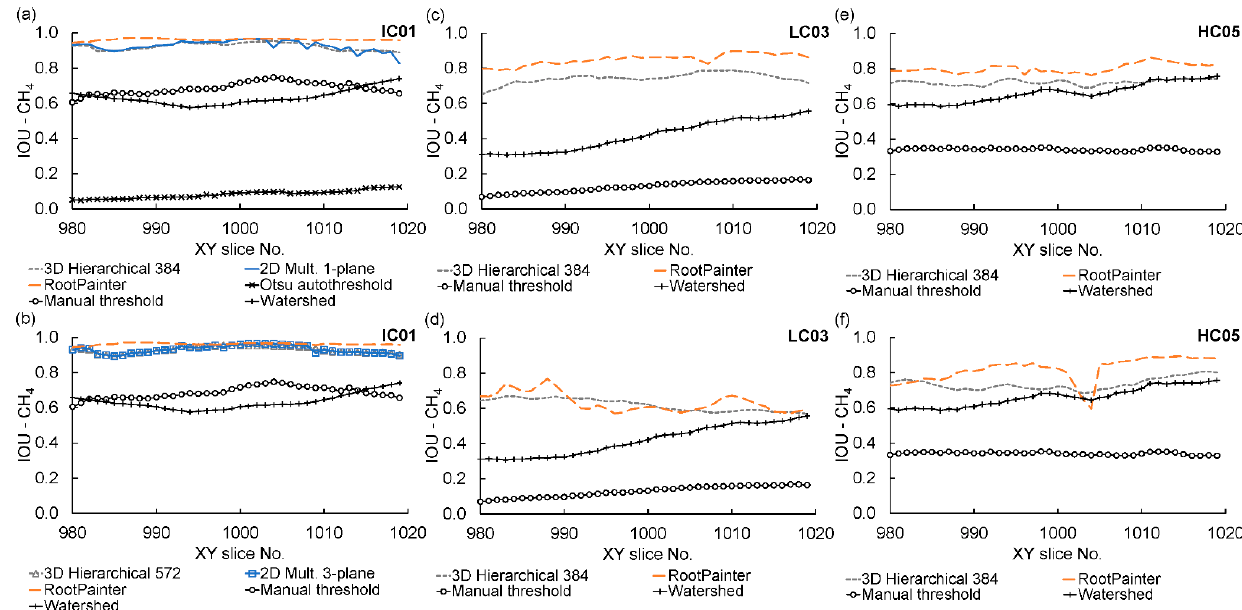
Figure 7. Performance metrics for the segmentation of CH 4 gas on the central 40 XY slices of: ( a ) IC01 using the 3D hierarchical, the single-axis 2D multilabel and RootPainter U-Nets; ( b ) IC01 using the 3D hierarchical (with the 2D learning subvolume), the multi-plane 2D multilabel and RootPainter U-Nets; ( c ) LC03 using the 3D hierarchical and Rootpainter U-Nets; ( d ) LC03 using the 3D hierarchical and RootPainter U-Nets trained on subvolumes from IC01; ( e ) HC05 using the 3D hierarchical and RootPainter U-Nets trained on subvolumes from IC01; ( f ) HC05 using the 3D hierarchical and RootPainter U-Nets trained on subvolumes from LC03. Watershed and thresholding results shown for reference. Table 3. Binary 3D hierarchical U-Net training metrics.